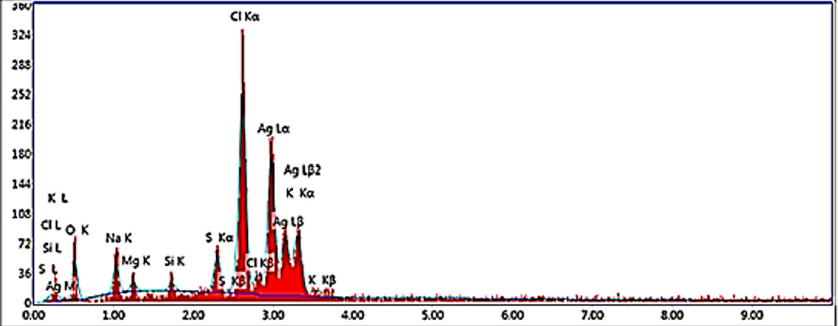
Figure 6: EDAX of Ag -